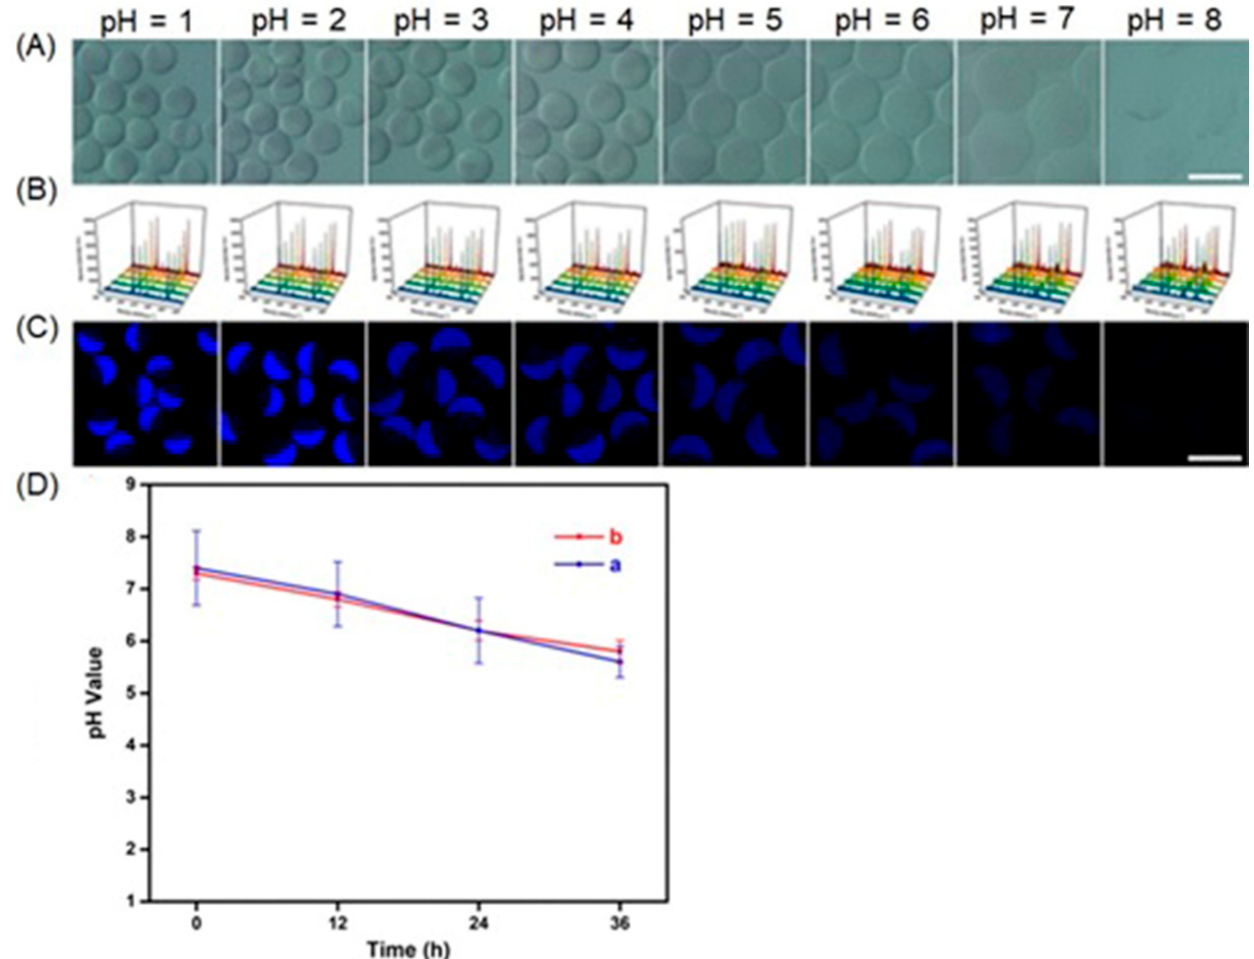
Figure 39. In vitro studies of Janus microgels. ( A ) Optical images of Janus microgels in buffer solutions with pH from 1.0 to 8.0 (scale bar = 200 µ m). ( B ) SERS spectra of SERS hemispheres in buffer solutions with pH from 1.0 to 8.0. ( C ) Confocal laser scanning microscopy fluorescence images of Janus microgels in buffer solution with pH from 1.0 to 8.0 (scale bar = 200 µ m). ( D ) Determination of pH values based on (blue, a) Raman intensity ratio of the peaks at 1395 and 1077 cm − 1 and (red, b) fluorescence intensity. Adapted with permission from Yue, S.; Sun, X.; Wang, N.; Wang, Y.; Wang,